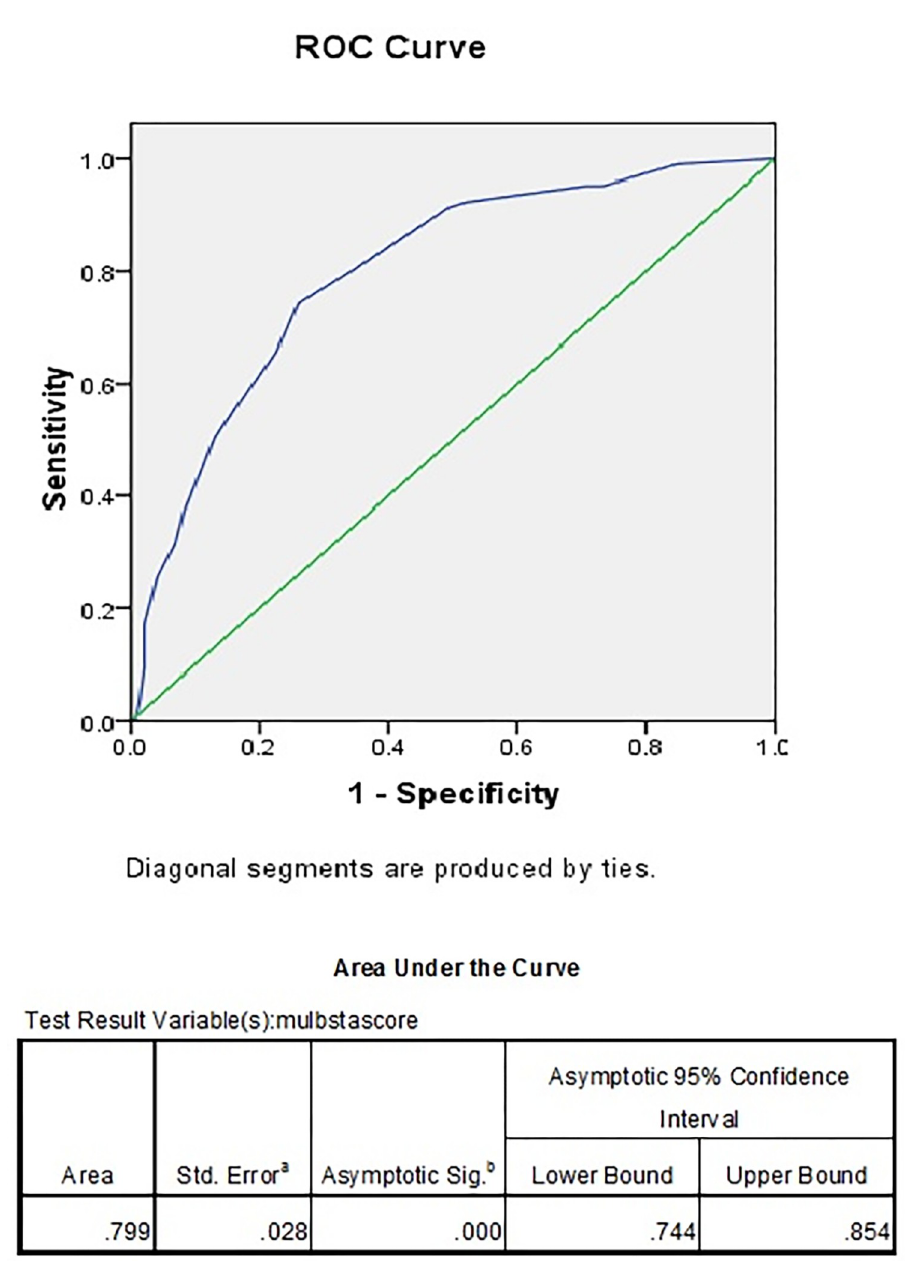
Fig 2. ROC of MuLBSTA score and